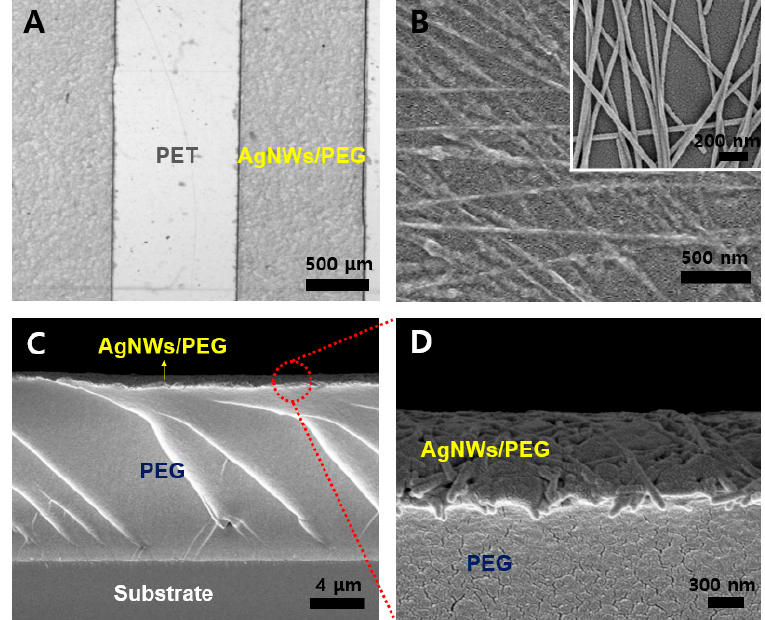
Figure 2. ( A ) Optical micrographs of AgNW-PEG patterns of line width 1 mm on PET. ( B ) FE-SEM micrographs of AgNW-PEG patterns on a PET substrate. (B inset) SEM micrograph of AgNW patterns on glass. ( C , D ) Cross sectional views of AgNW-PEG patterns of line width 1 mm on substrate.